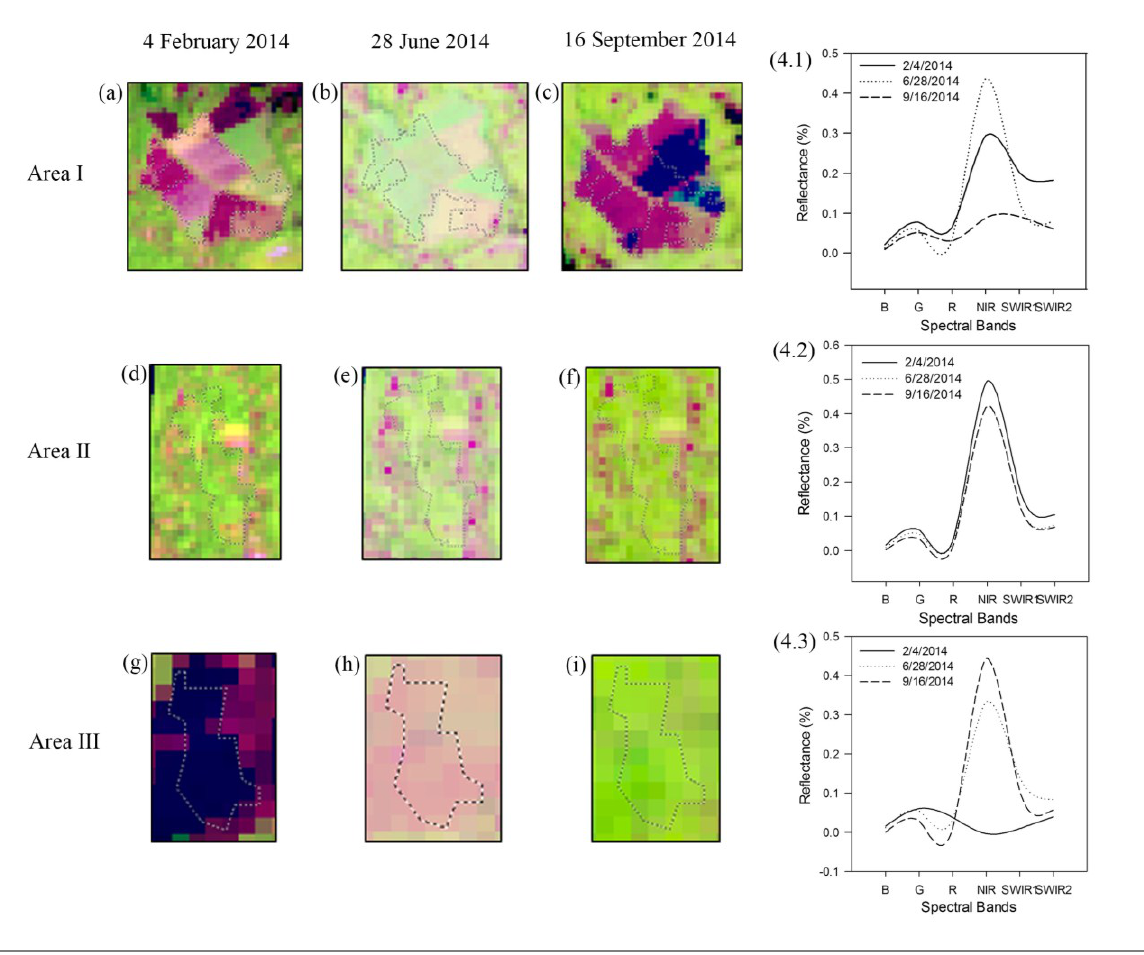
Figure 4. Landsat time-series imagery for three selected paddy areas ( a – i ); ( 4.1 ) spectral reflectance for area I; ( 4.2 ) spectral reflectance for area II; and ( 4.3 ) spectral reflectance for area